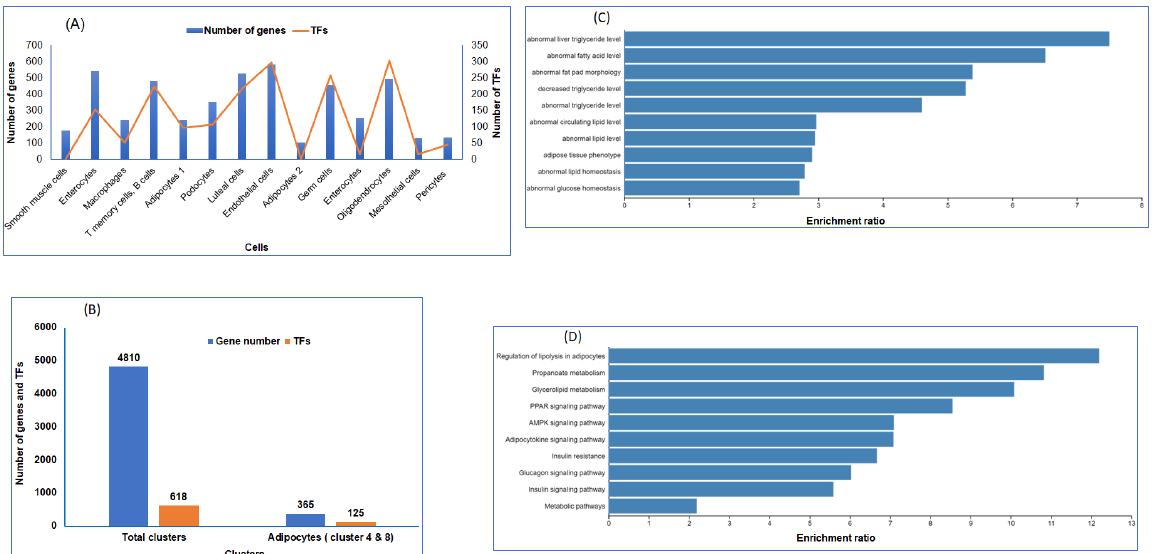
Figure 3. Transcription factors (TFs) of the differentially expressed genes in snRNA-seq. ( A ) TFs and gene numbers for each cell. ( B ) TFs and gene numbers for all cell clusters as well as cell types (clusters 4 and 8) which were identified as adipocytes. ( C ) Association of adipocyte DEGs and disease phenotypes in vWAT. ( D ) Association of adipocyte DEGs and metabolic KEGG pathways in